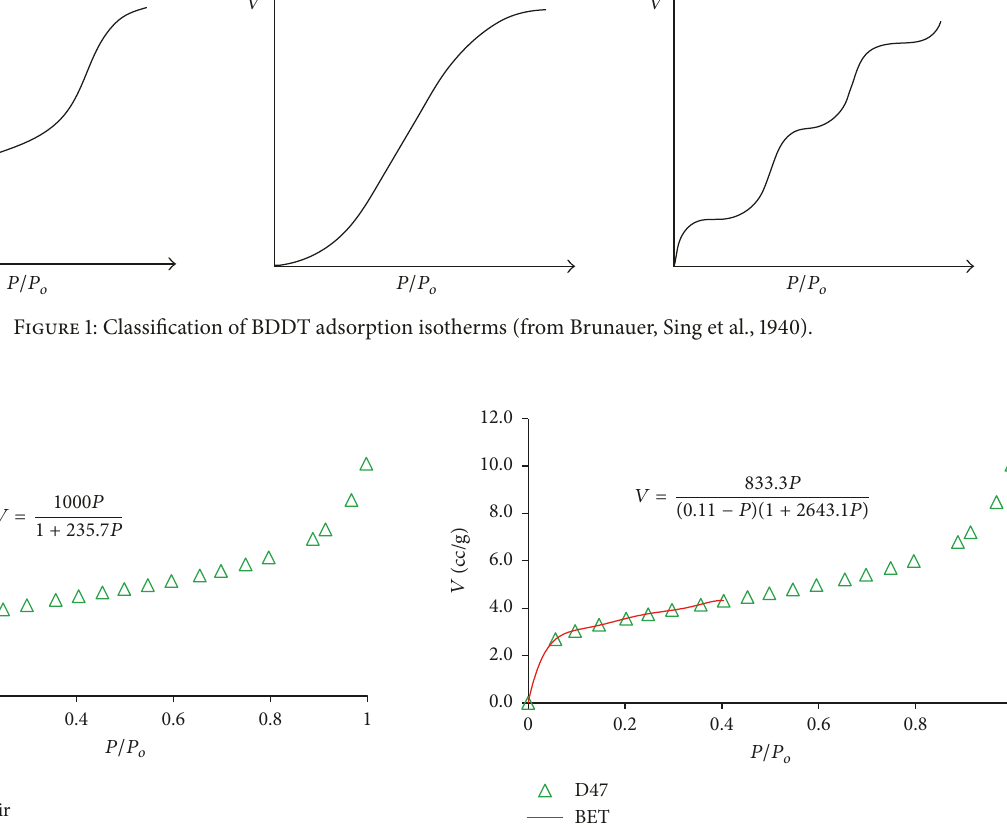
Figure 3: Application of BET isotherm to nitrogen adsorption isotherm for shale before capillary